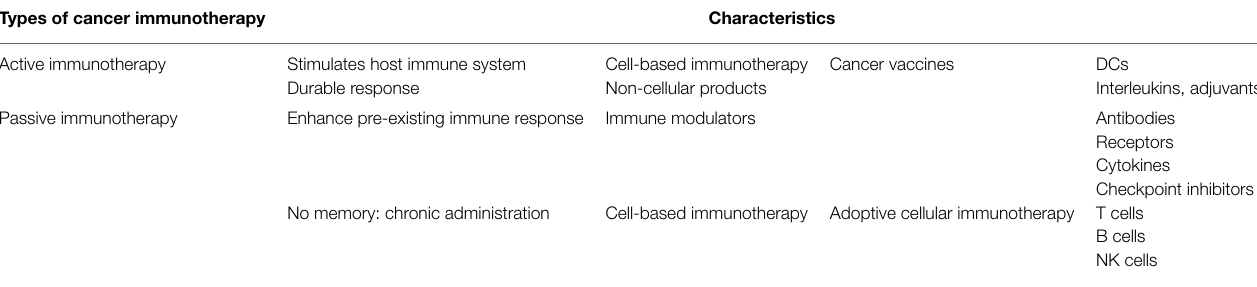
TABLE 1 | Comparison of cancer immunotherapies